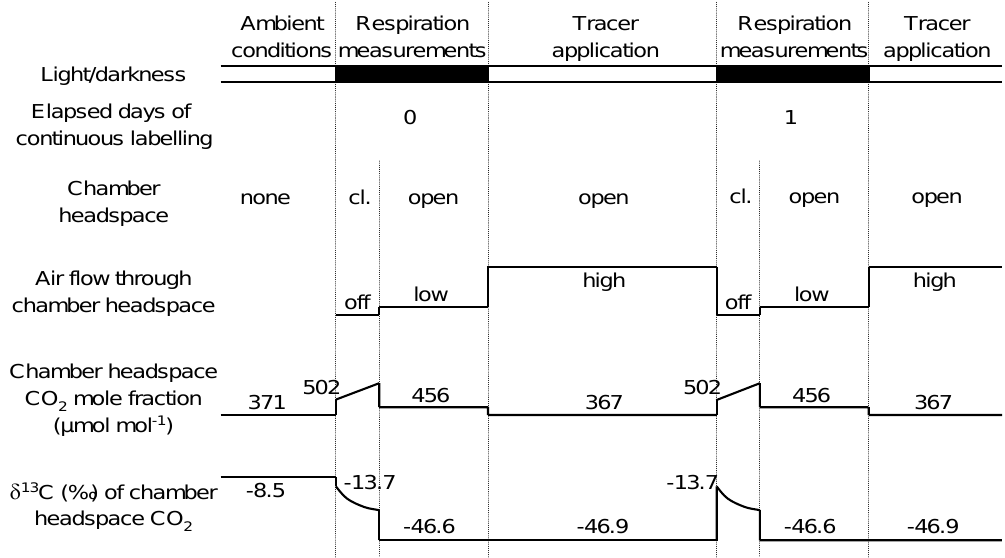
Fig. 1. Schematic sequence of labelling experiment, including chamber headspace conditions (cl.: closed) of air flow, CO 2 mole fraction and δ 13 C of CO 2 . The latter are shown as averages observed during the labelling experiment, and were used as input parameters in the model simulation. For closed chamber headspace, values are given at chamber